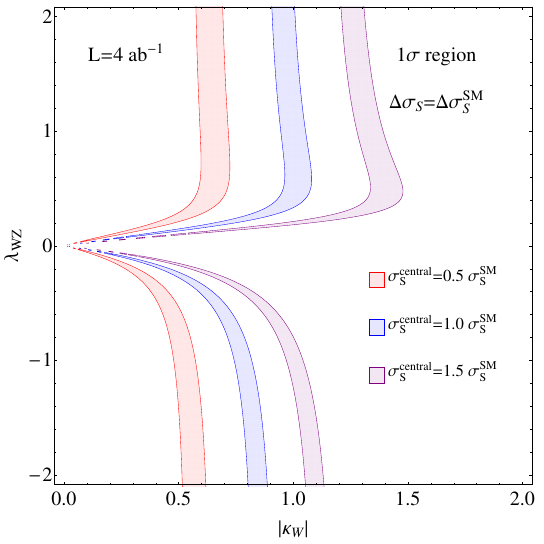
Figure 5 . 1 (cid:27) regions in the (cid:20) W - (cid:21) WZ plane when the measured signal cross section has the central j j (cid:27) SM value (cid:27) central = (0 : 5 ; 1 ; 1 : 5) and an error bar assumed to be the same as the SM expectation, S S (cid:2) assuming the 500 GeV ILC with the beam polarization P ( e (cid:0) ; e + ) = ( luminosity of 4 ab (cid:0) 1